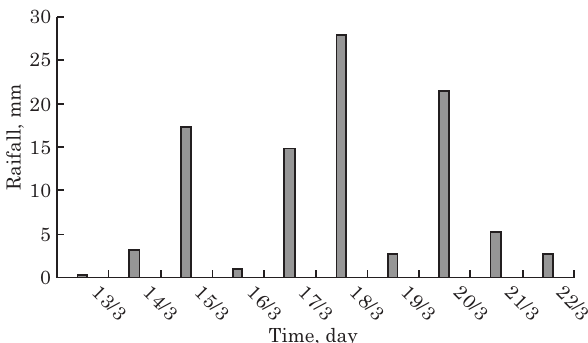
Figure 5. Rainfall for the entire simulation period.